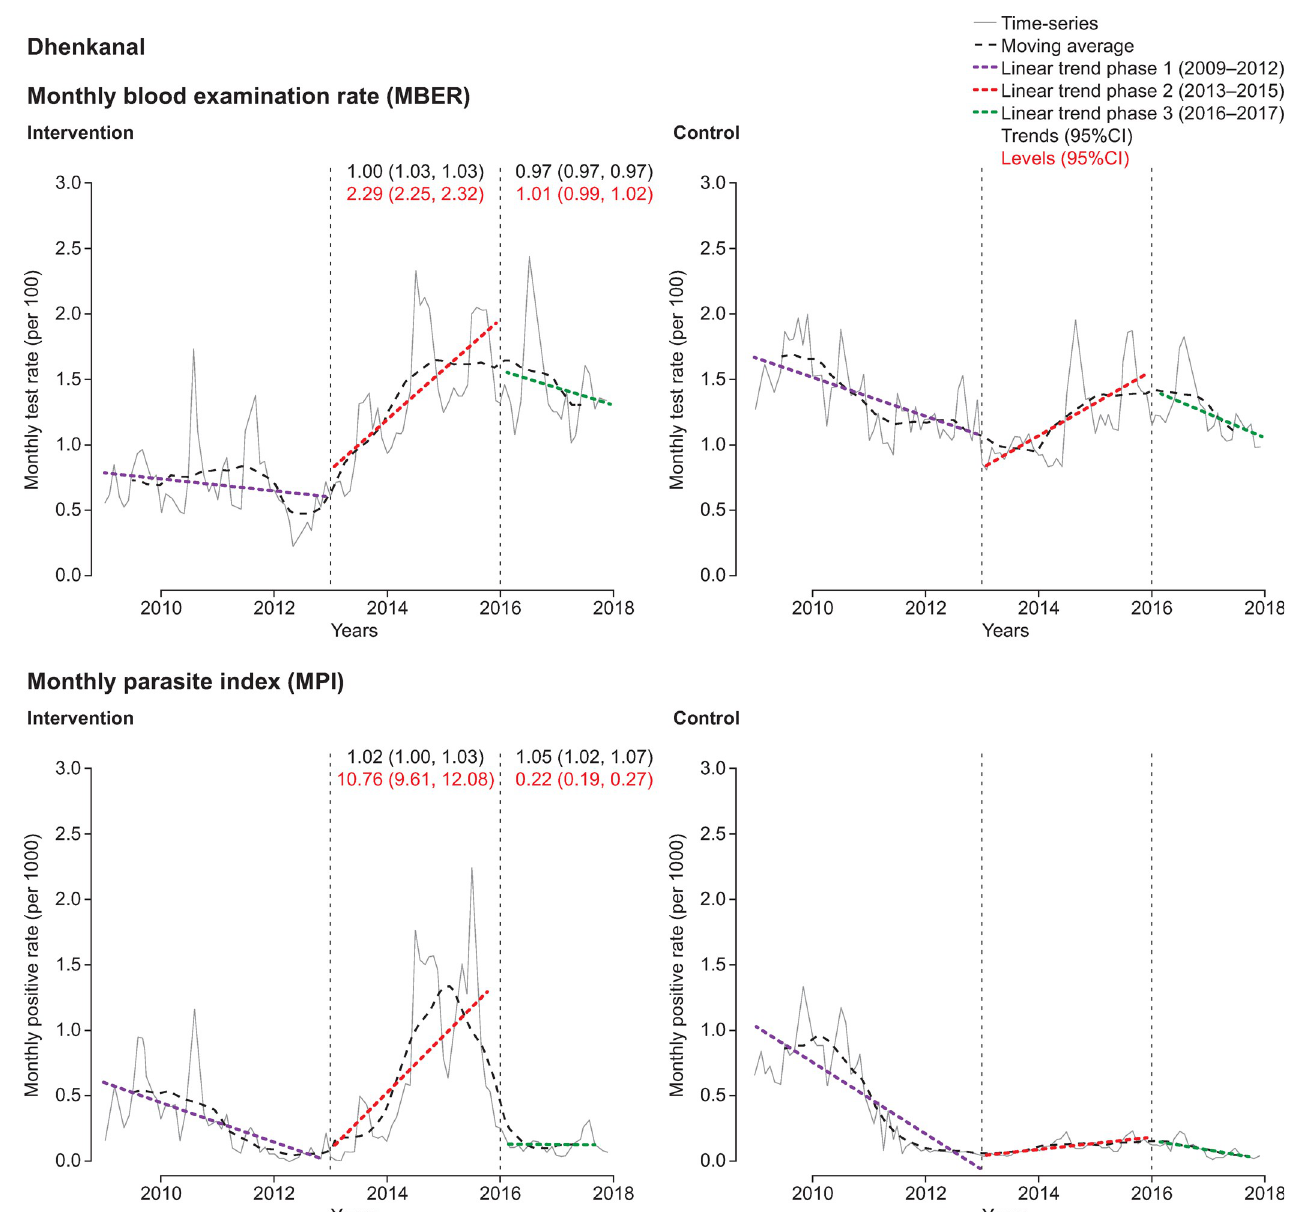
Fig 5. Interrupted time-series analysis of changes in malaria indices for Dhenkanal. MBER, monthly blood examination rate = total number of slides examined in a month x1000/total population; MPI, monthly parasite index = total number of positive slides for parasite in a month x1000 / total population.